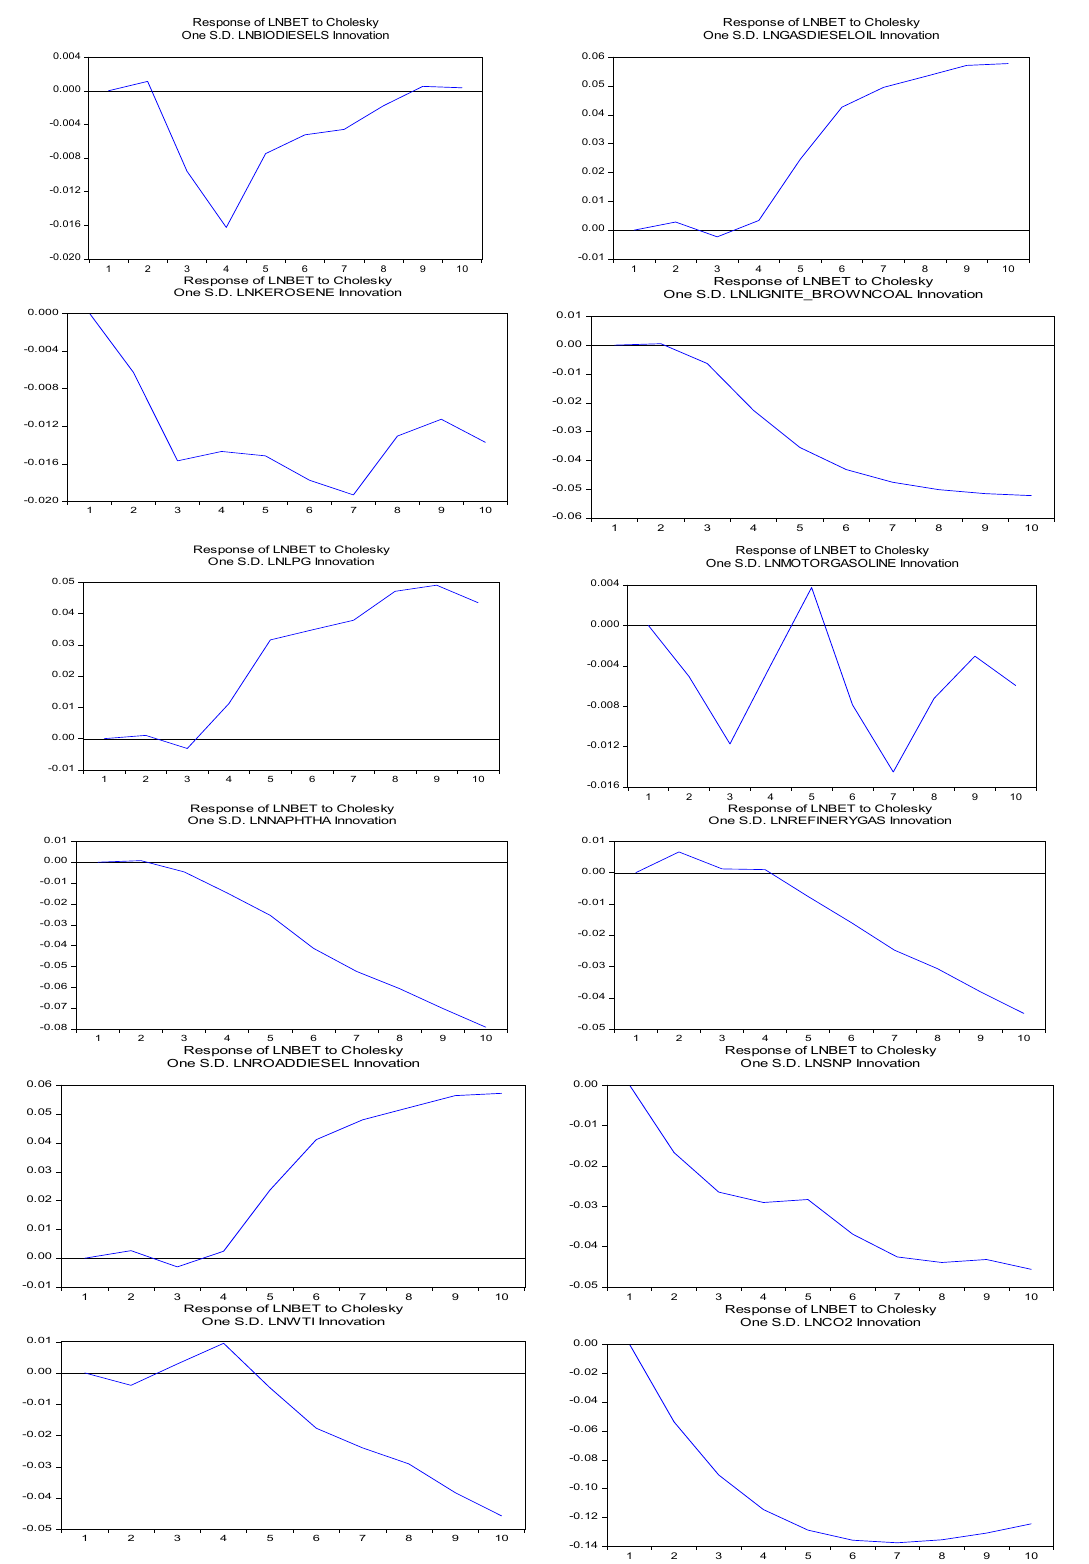
Figure 2. Impulse-response functions. Source: Authors’ work.